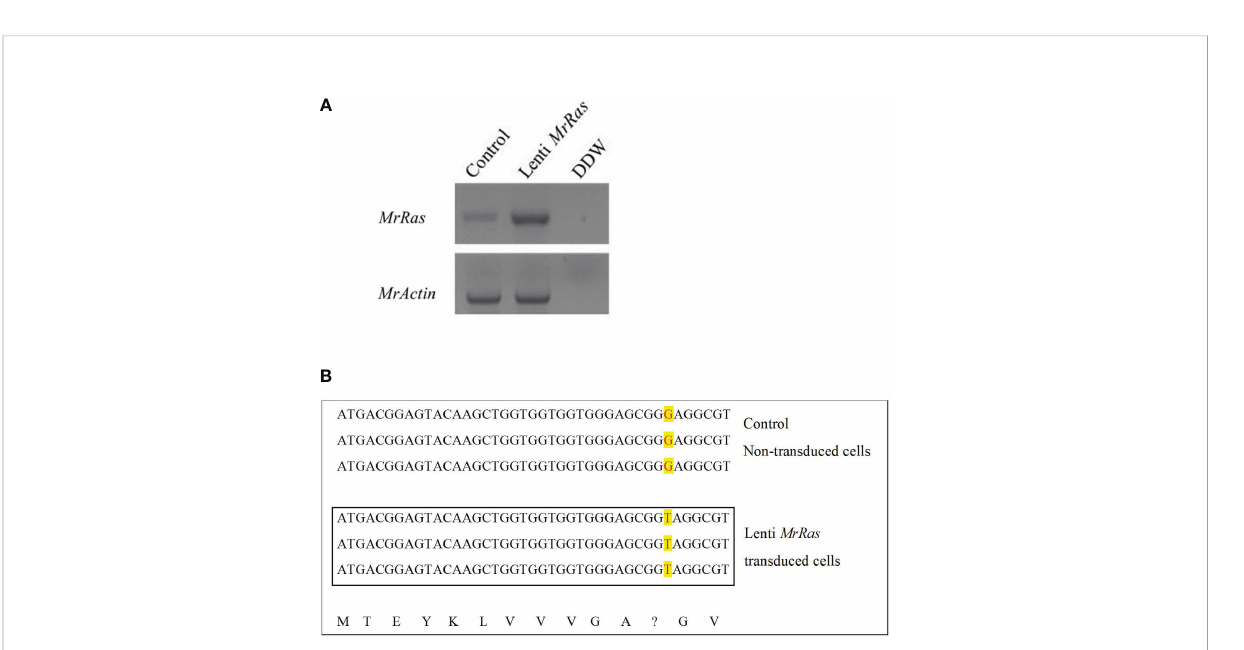
FIGURE 4 Integration of mutated lenti- MrRas into M. rosenbergii embryonic primary cell culture. (A) Gel of mutated Ras expression in transduced cells in culture (lenti- MrRas , top A). RNA extractions were performed after 18 days in culture. Control – non-transduced M. rosenbergii cells; DDW - doubly distilled water. MrActin served as the positive control (bottom). (B) Sanger sequencing of RNA isolated from control (top) and mutated lenti MrRas transduced cells (in box); the three lines in each box are biological replicates. The change in nucleotide from guanine to thymine may be seen in the mutated lenti- MrRas transduced cells compared to control cells (red over yellow background). The deduced amino acids from the sequences are presented in the bottom line. A question mark indicates the point